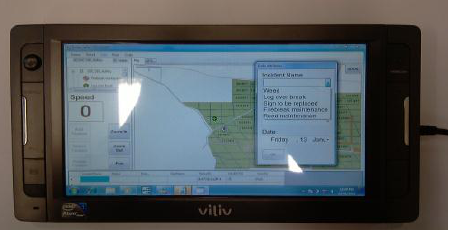
Figure 5. Illustration of the wetlands mobile GIS interface with the VILIV X70.